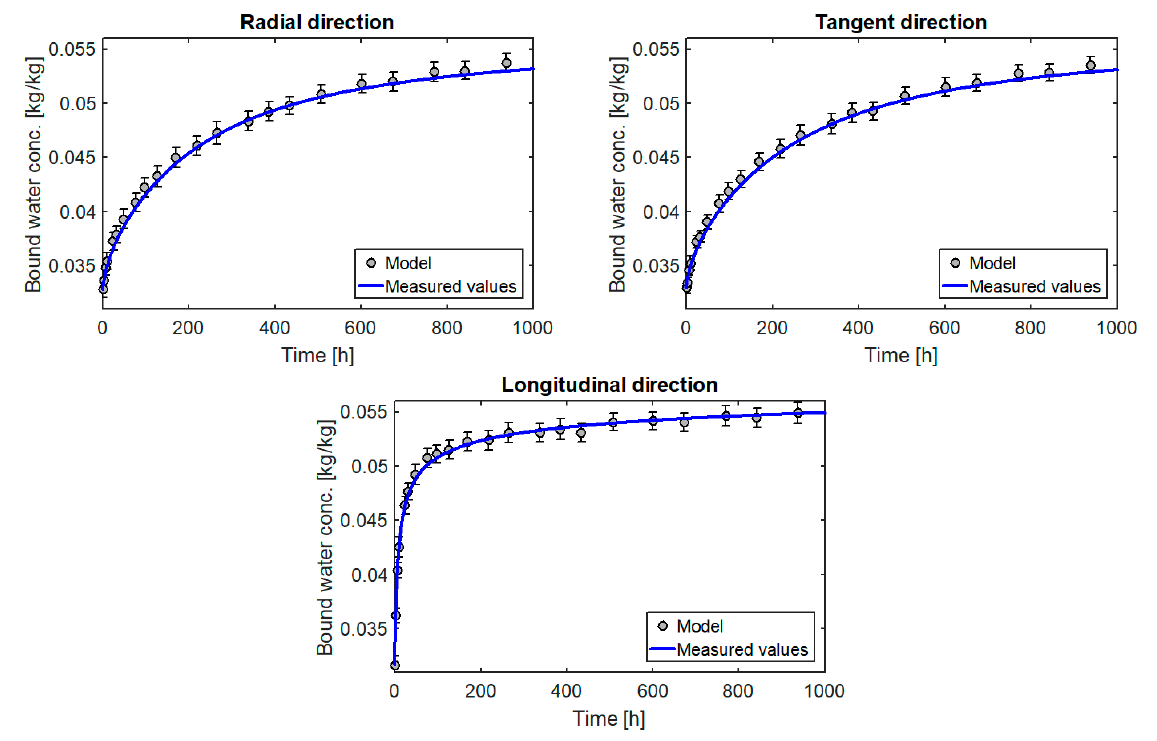
Figure 10. Changes in the moisture content of the oak samples versus time.